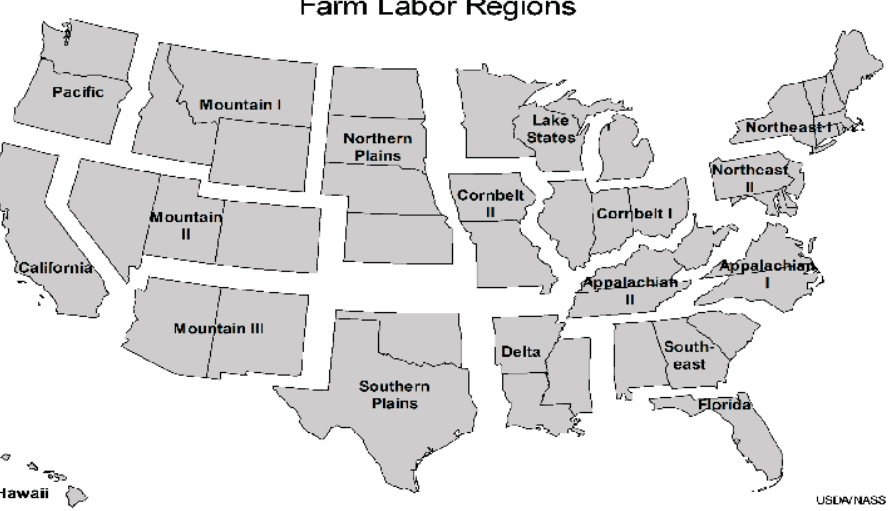
Figure 1. The regions for which farm labor estimates are developed.